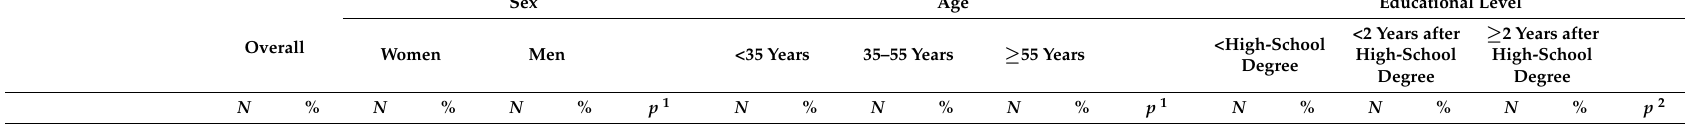
Table 5. Beliefs regarding the role of vitamin D in health conditions, overall and according to sex, age and educational level, NutriNet-Santé cohort, France